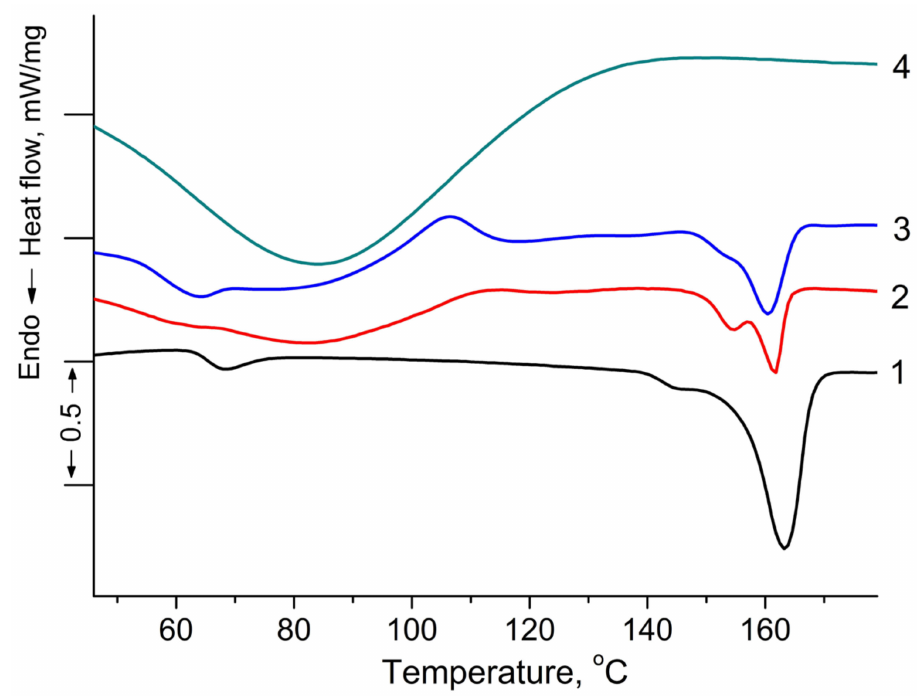
Figure 1. DSC heat flow curves of PLA: (1) PLA–chitosan (50:50) wt. % and (2) PLA–chitosan (50:50); wt. % compositions containing sorbed Fe 3+ ions (3) and original chitosan (4).